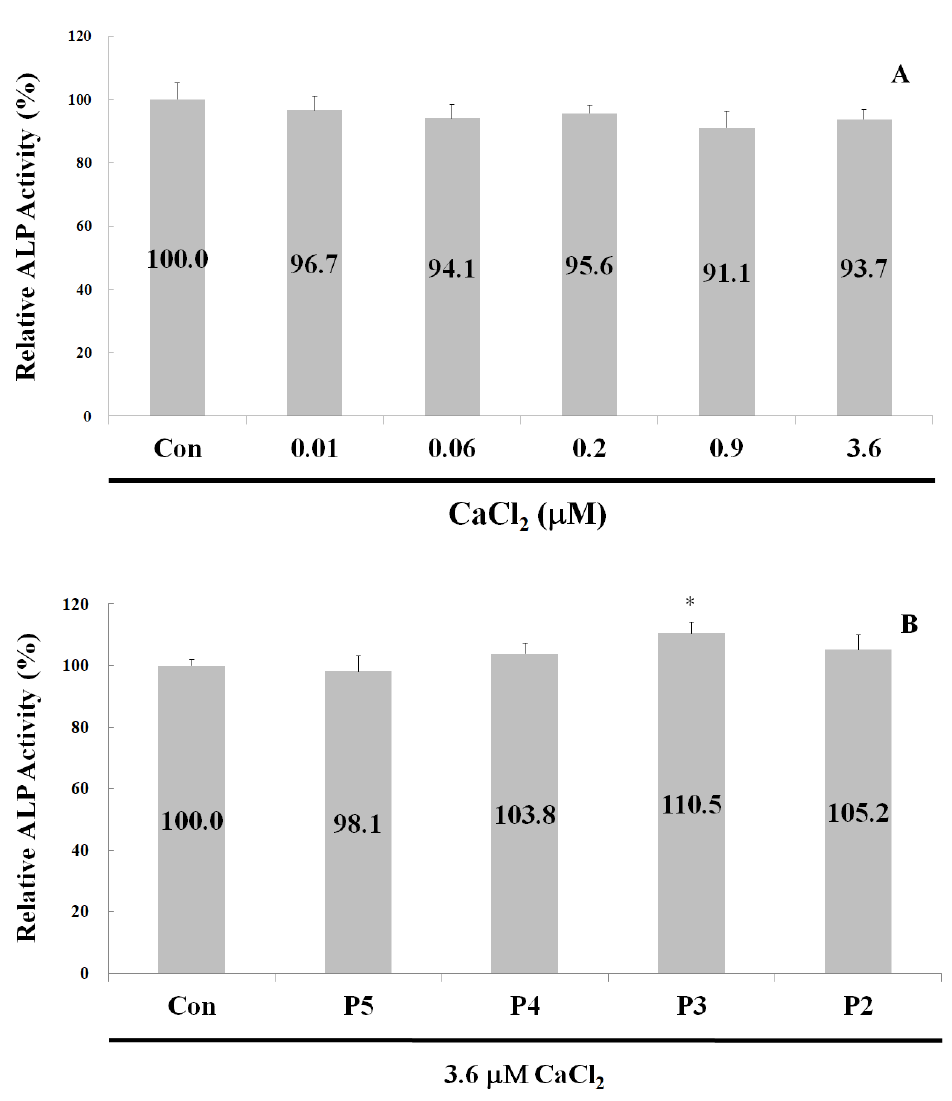
Figure 5. Alkaline phosphatase activity of osteoblasts hFOB1.19 after two days of treatment. ( A ) Treatment with various concentrations of CaCl 2 only. ( B ) Treatment with 0.45 µ M synthetic peptides and 3.6 µ M CaCl 2 . P5 = peptide 5; P4 = peptide 4; P3 = peptide 3; and P2 = peptide 2. Data are presented as means ± SD in three independent experiments. The differences between the various peptide treatment and the control groups were analyzed using a one - tailed test , * p < 0.05.